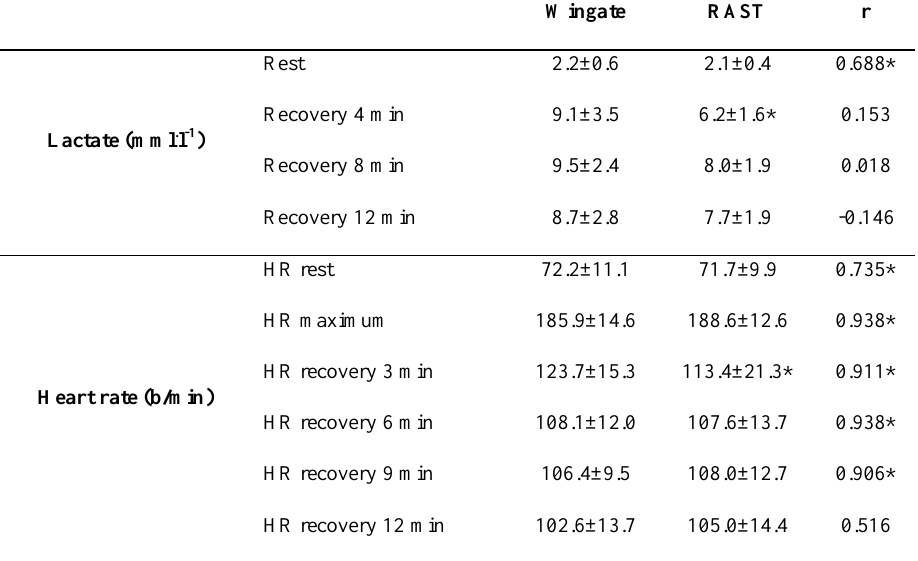
Table 2. Descriptive results (mean ± standard deviation) of blood lactate concentration and heart rate of cyclists for Wingate and RAST tests.